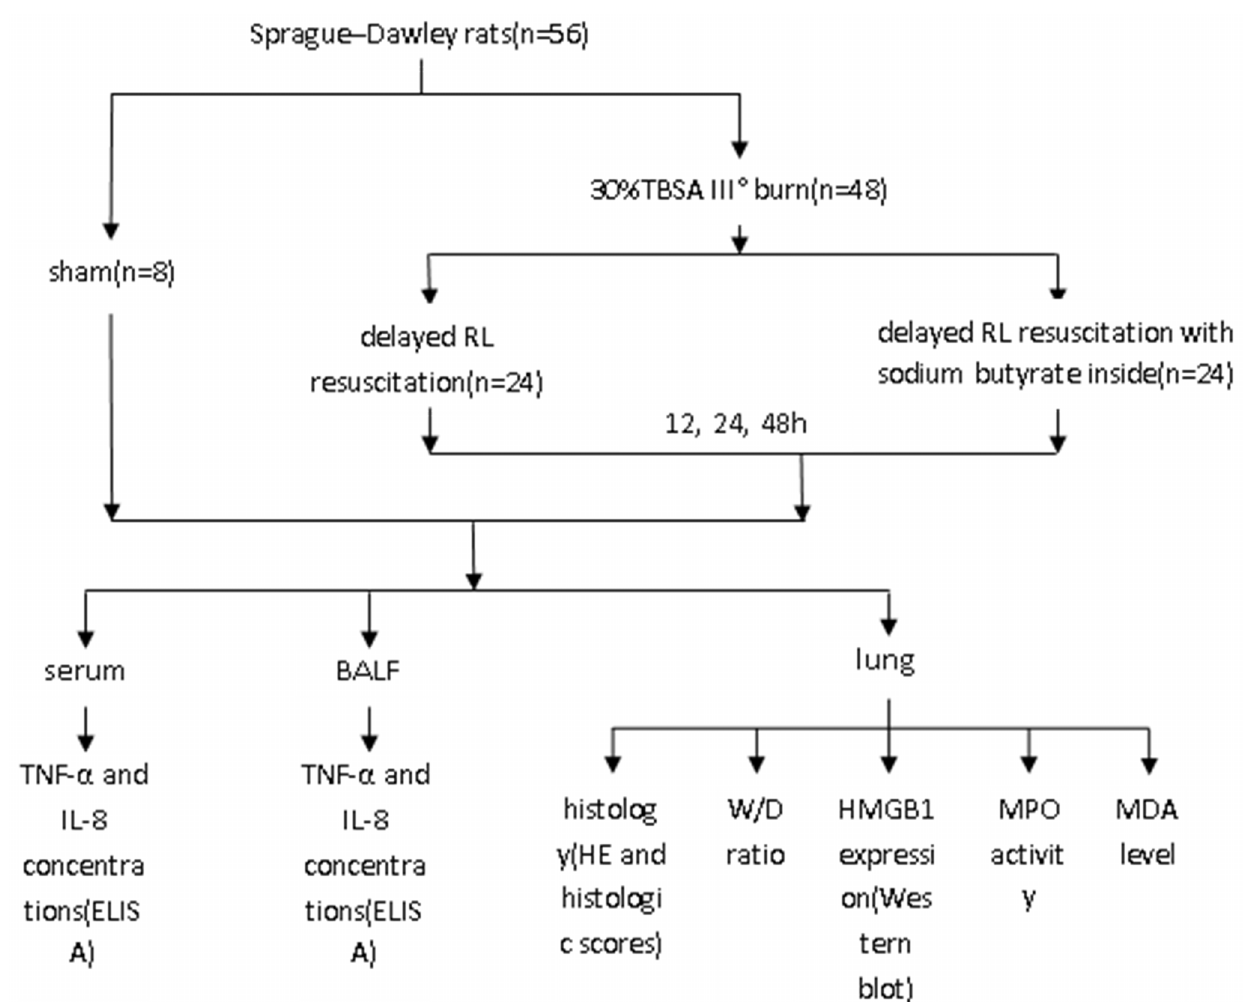
Figure 1. Experiment design.